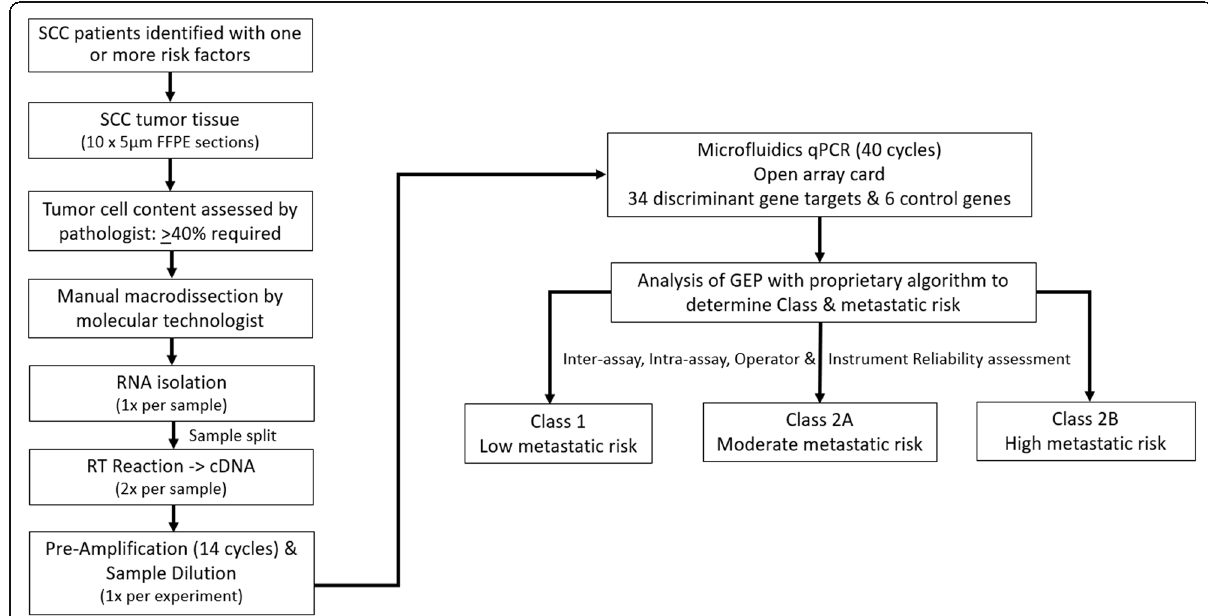
Fig. 1 Workflow schematic of the DecisionDx-SCC test describing the steps in the performance of the test and presenting the corresponding reliability